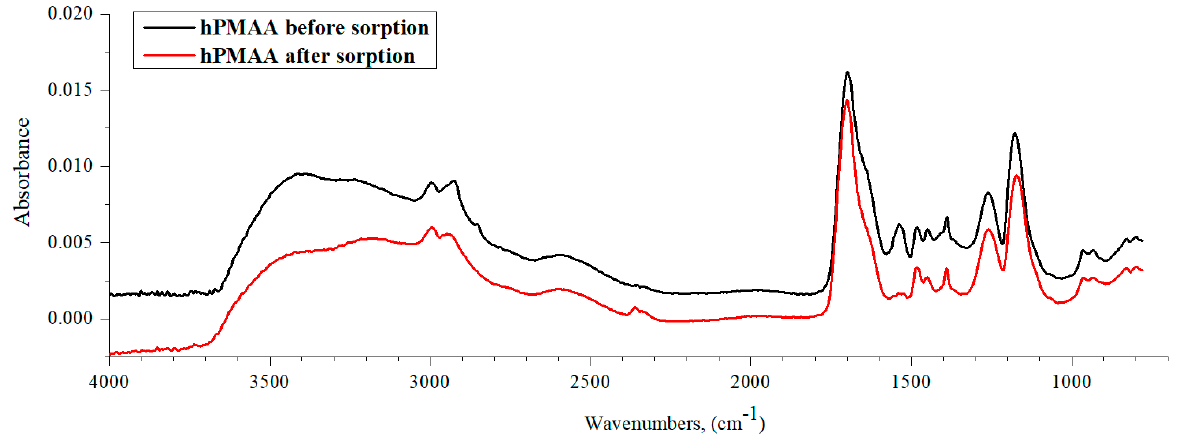
Figure 14. IR spectra of hPMAA before abd after lanthanum sorption by interpolymer system 50%hPMAA-50%hP2M5VP.